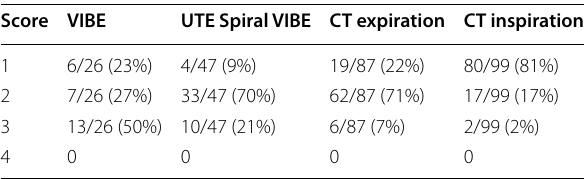
Table 4 Overview of the image quality for the MRI and CT examination